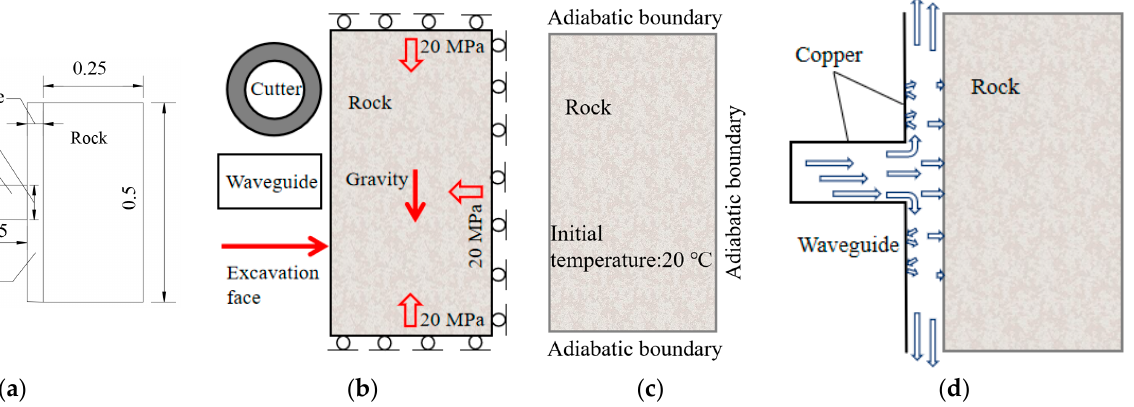
Figure 3. Schematic diagram of model geometry and boundary conditions. ( a ) Main parts and size (m); ( b ) mechanical BCs; ( c ) thermal BCs; ( d ) electromagnetic BCs.